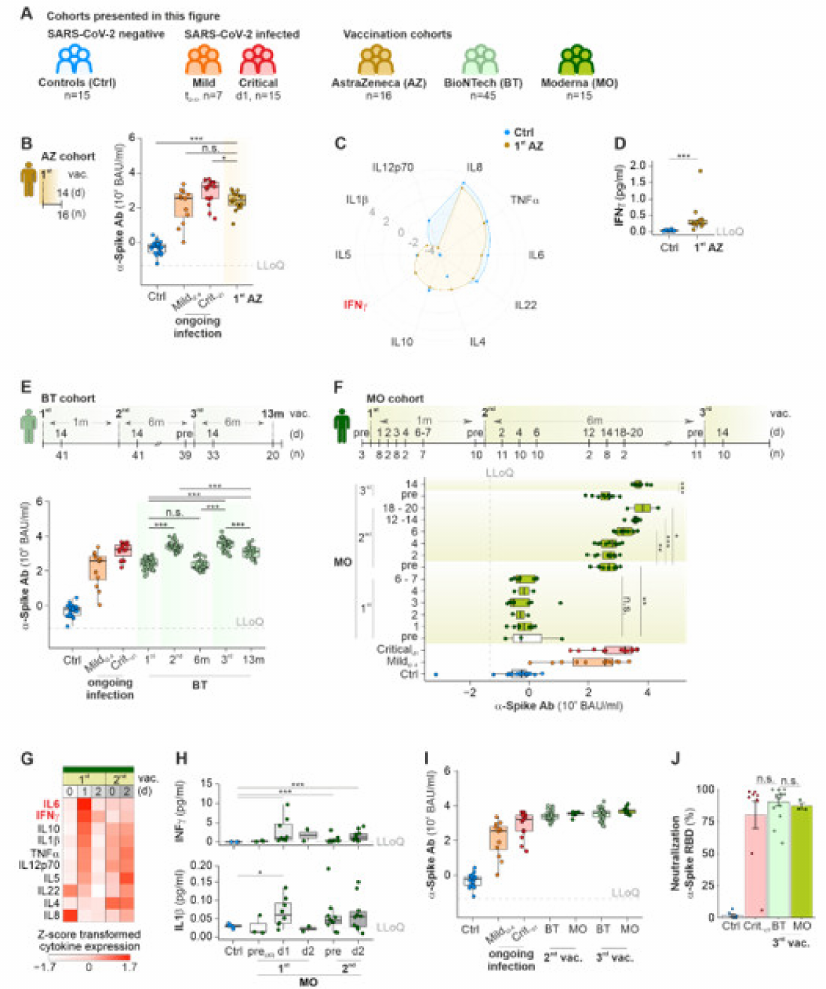
Figure 3. Dynamics of Ab titers against Wuhan SARS-CoV-2 Spike-protein in different vaccination regimens. ( A ) Scheme of vaccination cohorts and groups of SARS-CoV-2 infected patients. ( B – D ) Concentrations of α -Spike-Ab ( B ), cytokines ( C ) including IFN ϒ ( D ) in sera of participants 14 d after vaccination with AZ. ( E , F ) Scheme of vaccination strategy and longitudina l analysis of α -Spike-Ab titers in participants multiple times vaccinated with BT ( E ) or MO ( F ). ( G ) Heatmap of Z-score transformed cytokine concentrations in blood of participants vaccinated with MO before and shortly af- ter the vaccination. ( H ) Cytokine concentrations for IFN ϒ (top) and IL1β (bottom) before and after vaccination with MO. ( I ) Comparative analysis for α -Spike-Ab titers after multiple inoculations with mRNA vaccines. ( J ) Neutralization capacity of antibodies against α -Spike-RBD of SARS-CoV-2 in healthy non-vaccinated controls, critically ill COVID-19 patients, and vaccinated individuals with BT and MO six months after the second booster. LLoQ, Lower Level of Quantification; Mann–Whitney U test, un-adjusted p -value (A), adjusted p -value (B, E); * p Val < 0.05, ** p Val < 0.01, *** p Val < 0.001. An initial vaccination with Comirnaty from Pfizer–BioNTech induced α -Spike-Ab titers in healthy participants comparable to COVID-19 patients with ongoing SARS-CoV-2 infection at early time points (medians for Mild t2–4 : 369 BAU/mL; 1st BT: 272 BAU/mL; Figure 3E). Similar to the AZ-vaccination and active ongoing SARS-CoV-2 infections, α -Spike-Ab titers against SARS-CoV-2 variants were reduced by up to 50% (Supplementary Figure S3C). The second vaccination with BT led to a significant booster effect with increased